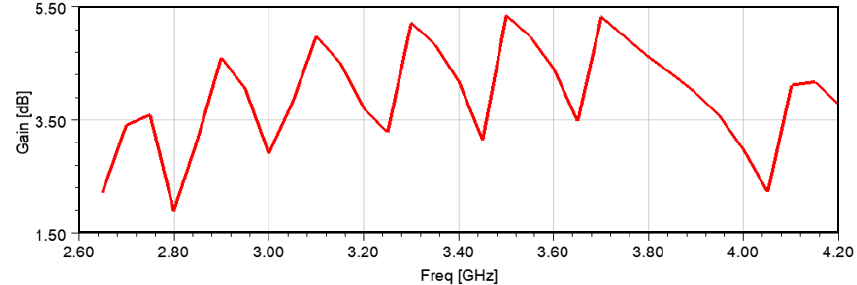
Figure 5. Peak realized gain of the proposed antenna 1.